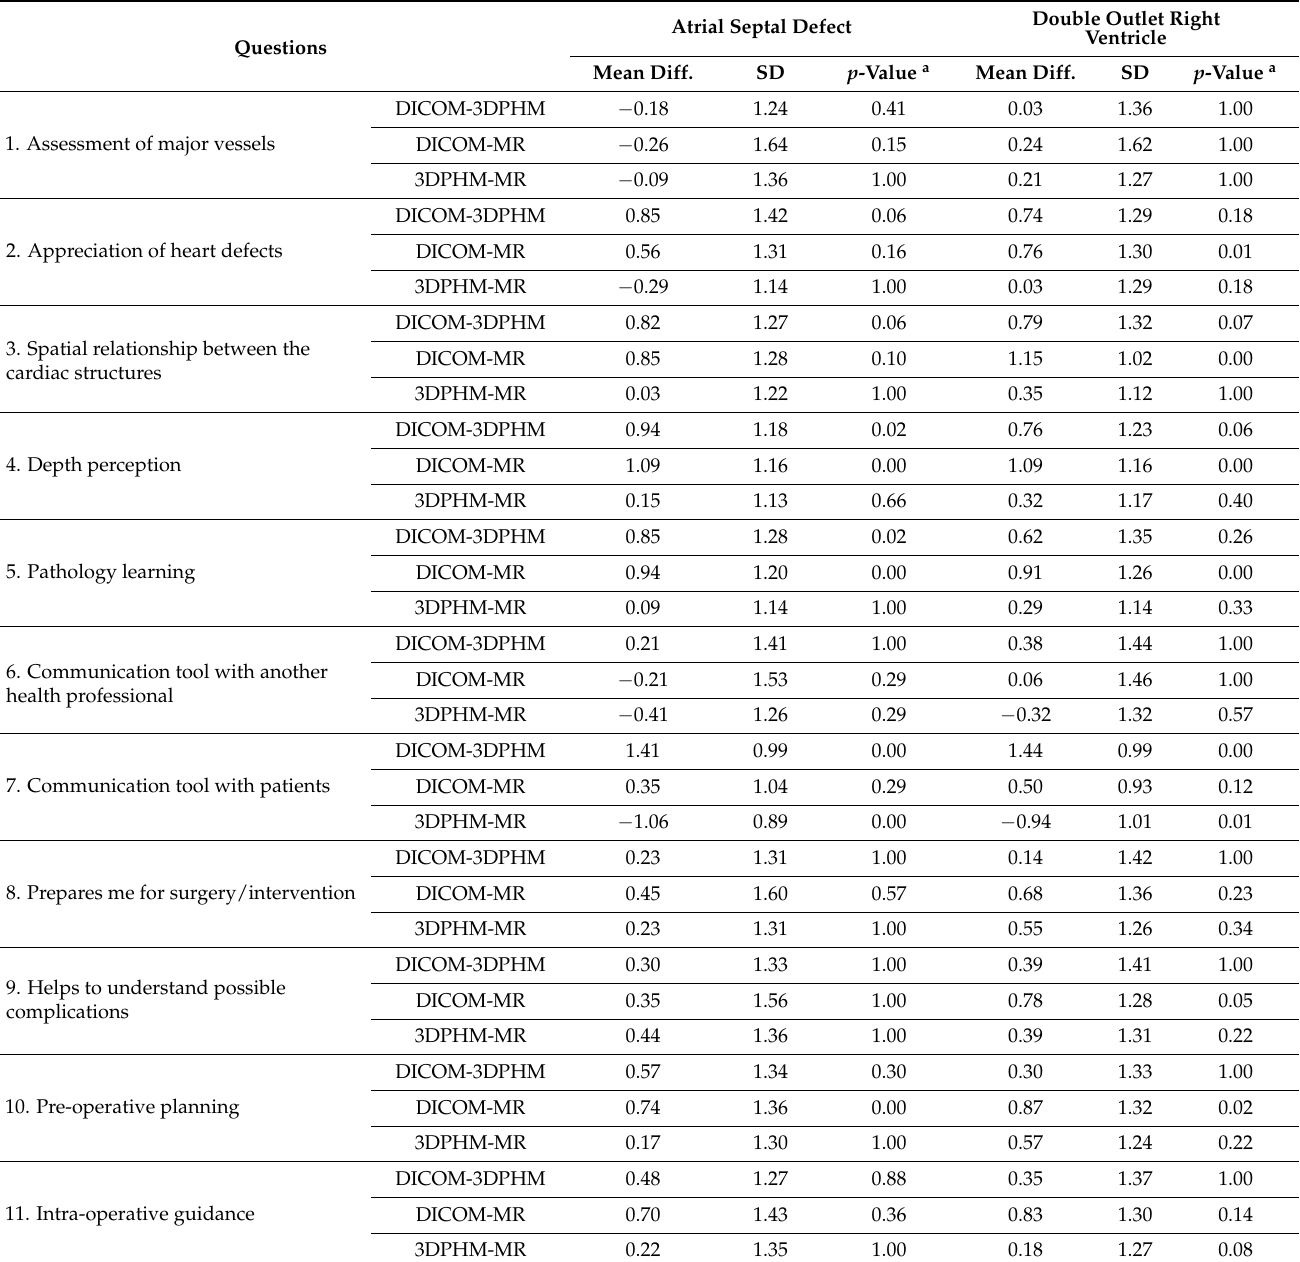
Table 3. Mean differences between modalities and significance values of pairwise